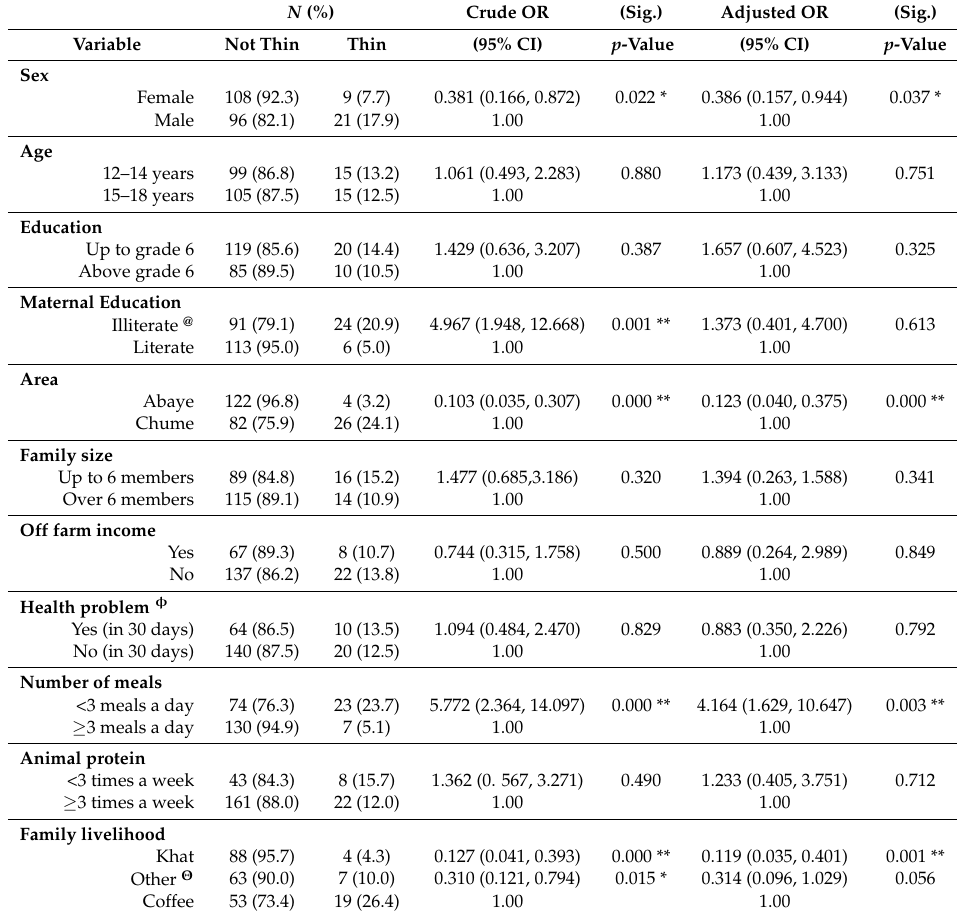
Table 3. Multivariate analyses of risk factors for the thinness of adolescents in the Sidama Zone, Southern Ethiopia. N (%) Crude OR (Sig.) Adjusted OR (Sig.) Variable Not Thin